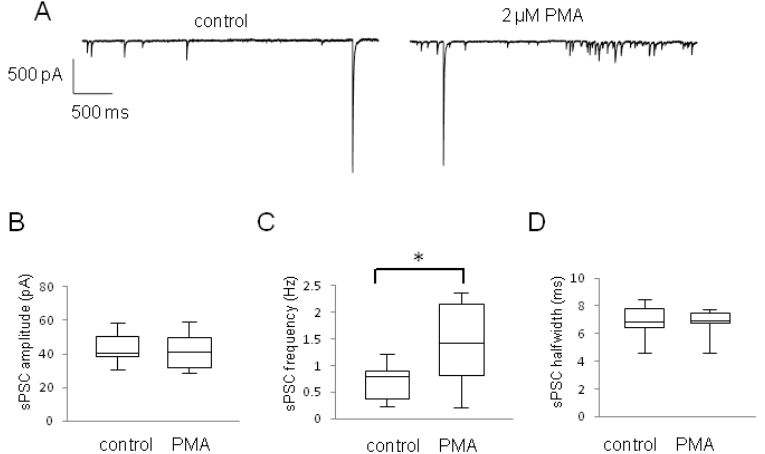
Figure 1. Effects of PMA on nociceptive transmission in dorsal horn neurones. ( A ) Raw data traces showing effects of PMA (2 M) on control sPSCs (holding potential (V Box and whisker plots showing effects of PMA (2  M) on ( B ) sPSC amplitude ( C ) sPSC frequency and ( D ) sPSC half-width. In these plots, the median value is represented by central bars, 25% and 75% quartile ranges depicted by boxes, max/min values represented by “error” bars. ( E ) Bar graph showing summarised effects of PMA (2  M) on normalised sPSC frequency. ( F ) Cumulative frequency plots for effect of PMA (2  M) on control sPSC inter event interval; data sets significantly different using KS -test. (B–F) n = 6  S.E.M., * = p < 0.05 (Mann Whitney U